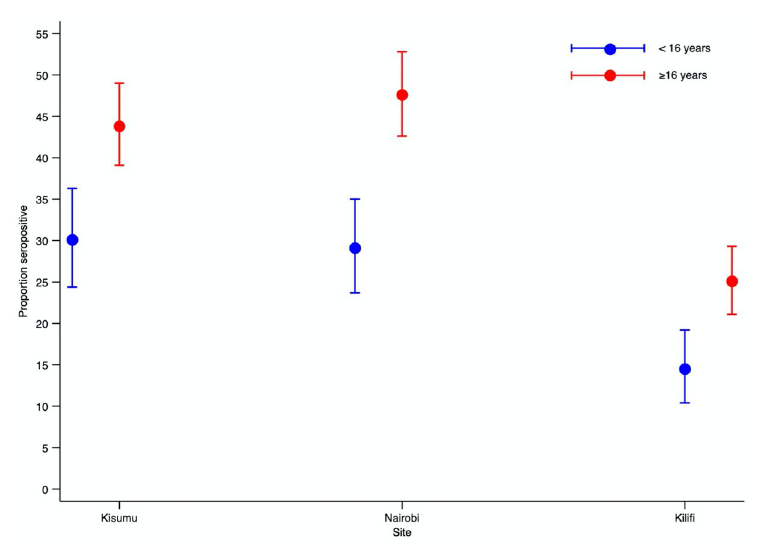
Fig 3. Seroprevalence in children and adults by HDSS site. Seroprevalence estimates were obtained using Bayesian threshold analysis adjusted for test performance and underlying population structure using multilevel regression and poststratification Error bars indicate 95% Credible